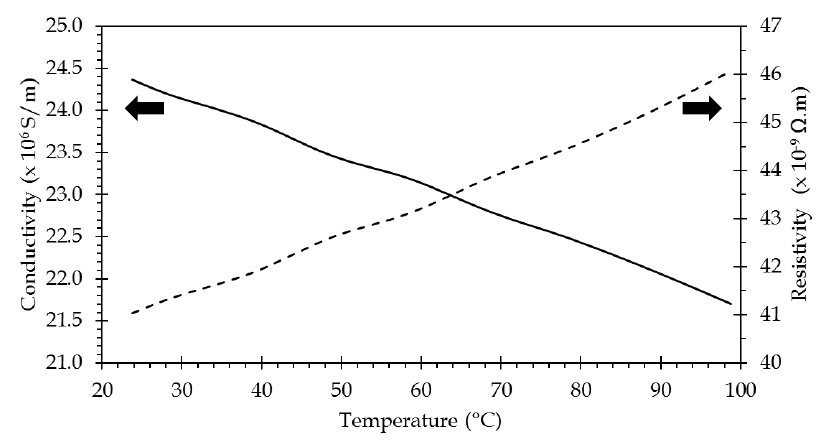
Figure 3. Electrical properties of the plasmonic layer gold film versus temperature.